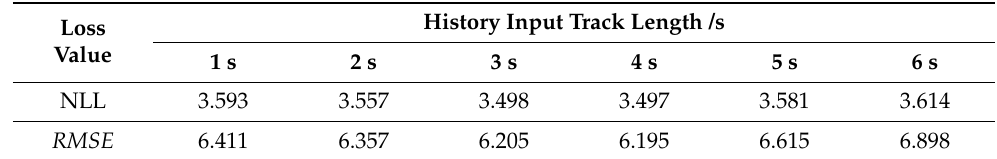
Table 3. Comparison of historical trajectory model errors of each